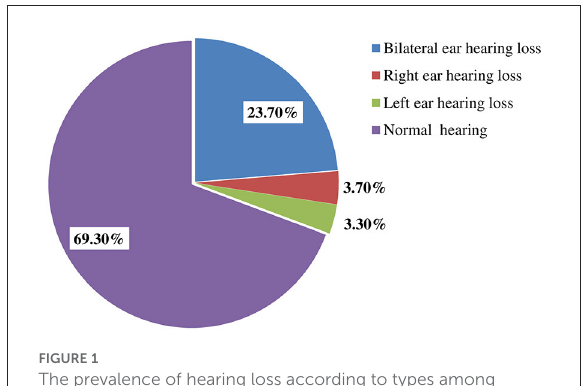
FIGURE1 The prevalence of hearing loss according to types among metalworkers in Gondar city, Northwest, Ethiopia.